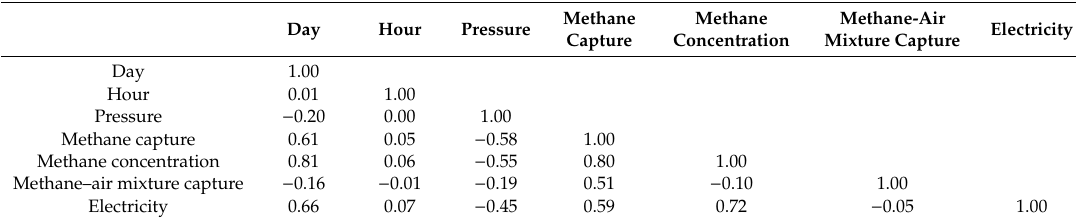
Table 6. Descriptive statistics for input and output